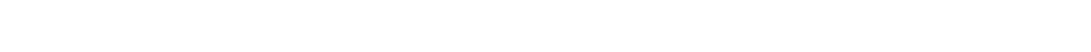
FIGURE 1 | Mean grand-averages ERPs forWelsh and English stimuli over medial and midline sites in late and early bilinguals. Negative is plotted